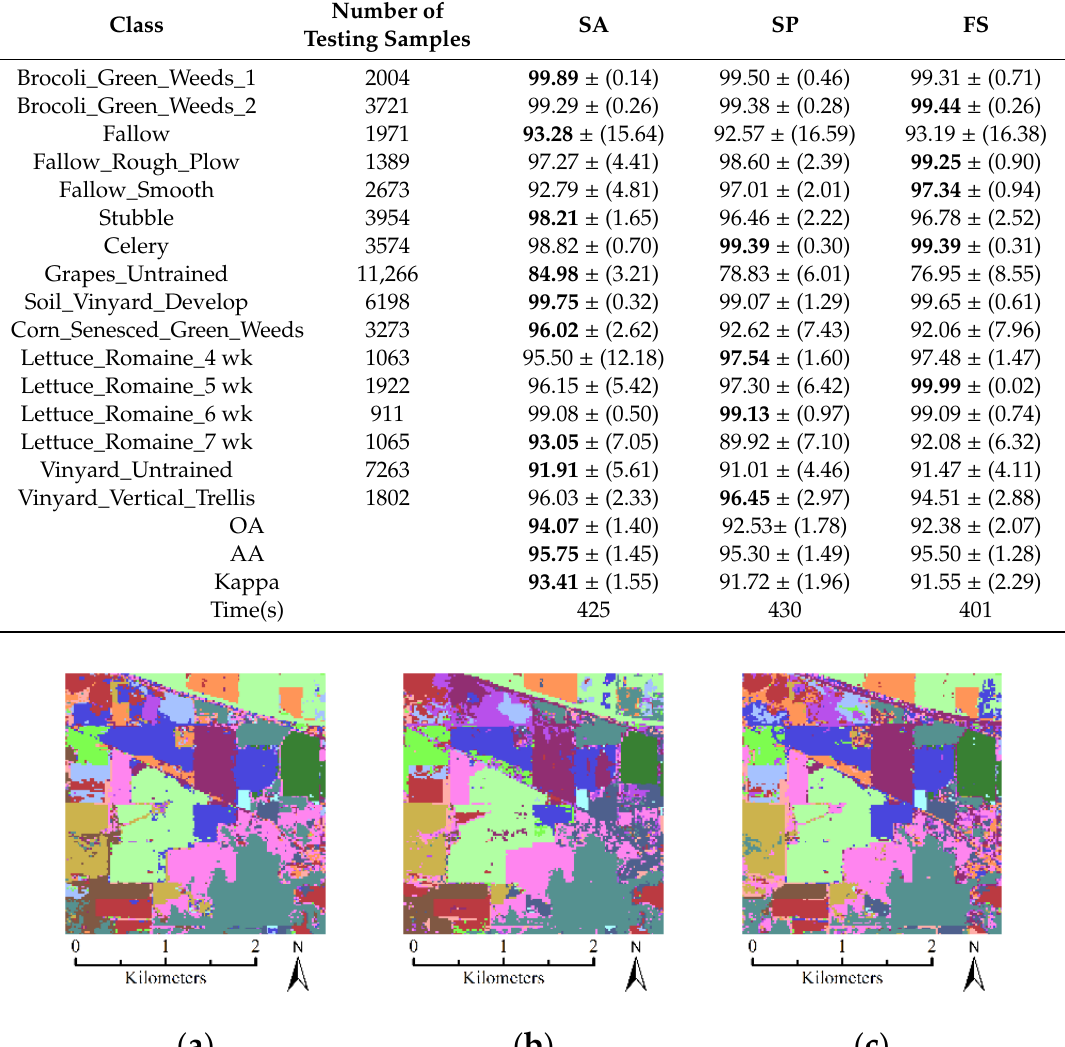
Table 3. CAs, OAs, AAs, kappa (as a percentage, with the standard deviation in brackets), and running time average statistics obtained with unlabeled samples selected from SA-, SP-, and FS- based neighborhood for Salinas Valley dataset.